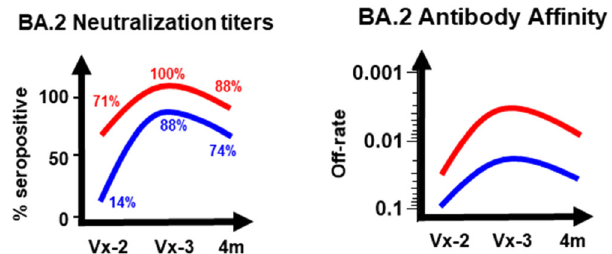
Fig. 4 | Durability of vaccination-induced SARS-CoV-2 vaccination-induced immunity against Omicron BA.2. Schematic highlighting the durability of SARS- CoV-2vaccination-induced antibodyresponse innaive(blue)vsconvalescent(red) adults shown as percent seropositivity of neutralization titers and spike antibody af fi nity against SARS-CoV-2 Omicron BA.2 following second and third mRNA